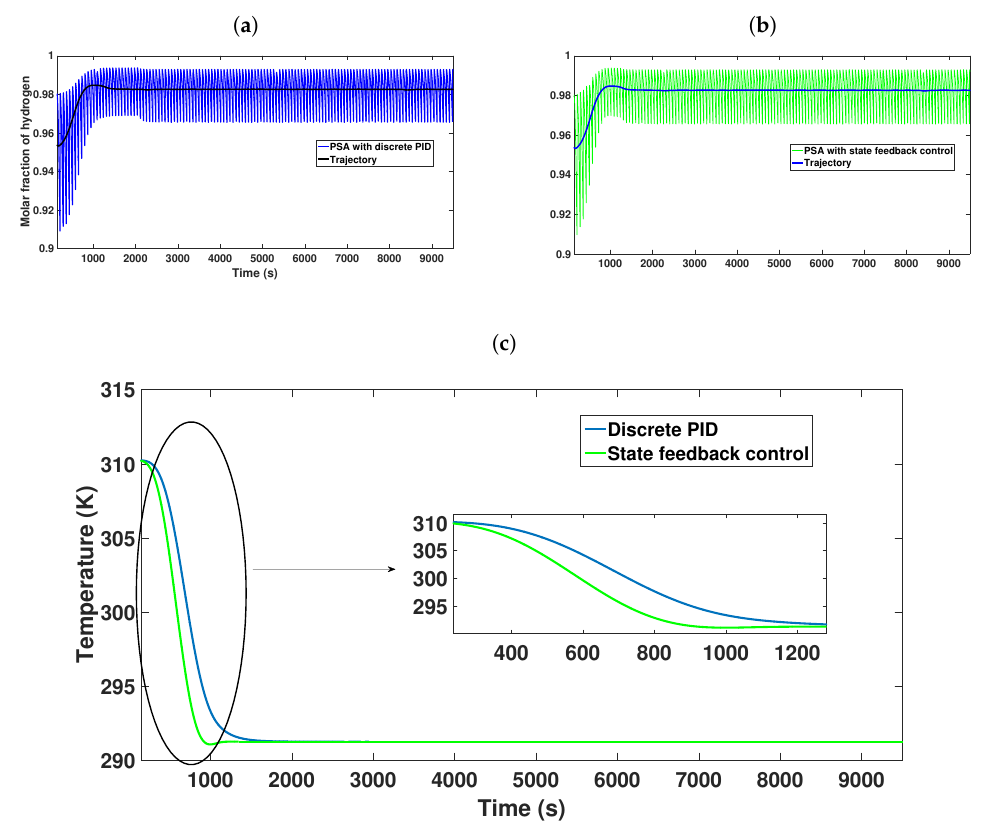
Figure 18. Validation of the controllers from a change of trajectory. ( a ) Purity obtained with trajectory tracking from the control signals generated by the discrete PID. ( b ) Purity obtained with trajectory tracking from the control signals generated by state feedback. ( c ) Discrete PID and status feedback control